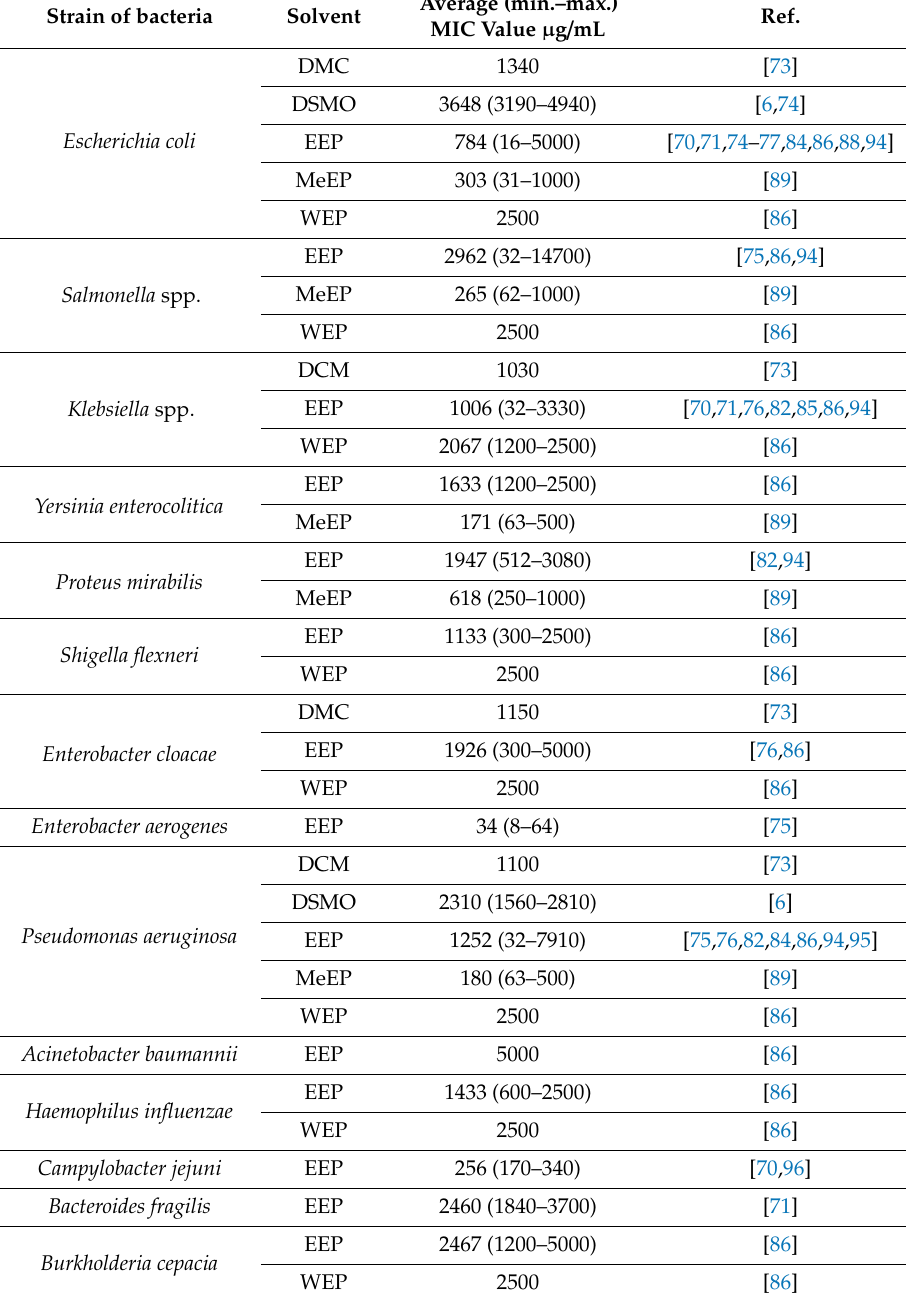
Table 2. The activity of di ff erent propolis’ extracts against Gram-negative